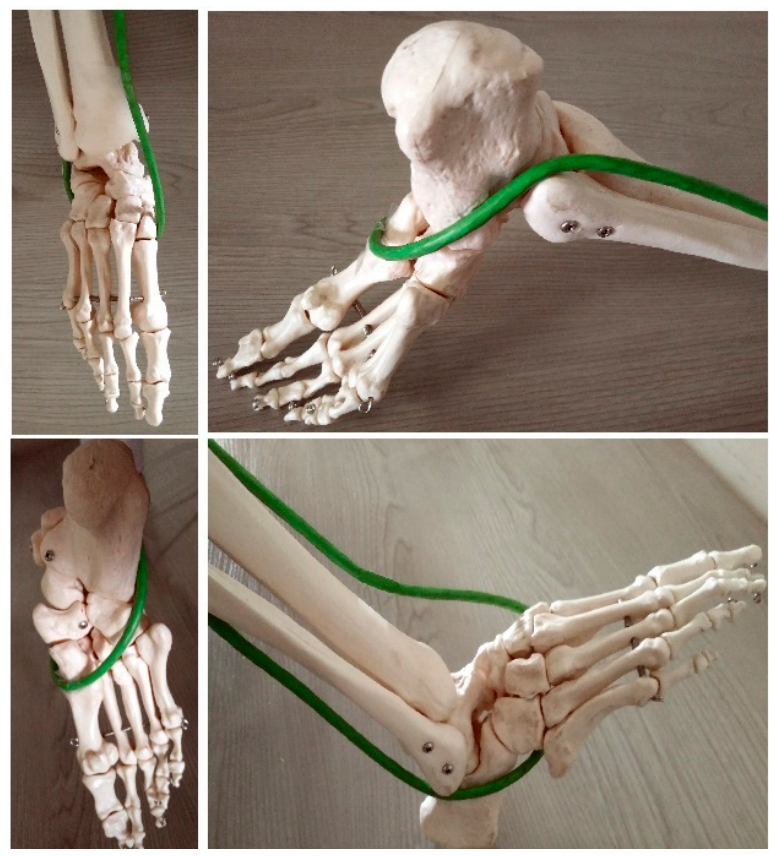
Figure 2. Model of the tendon stirrup (projections of the four basic surfaces of the foot). Two tendons, namely the anterior tibial and fibularis longus muscles, having adjacent inserts on two bones (at the base of metatarsal bone I (plantar side) and medial cuneiform bone) functionally form one system (green loop), constraining the transverse arch and lifting the longitudinal arch of the foot.